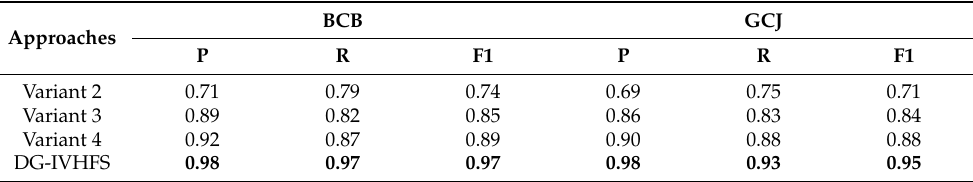
Table 4. The ablation experiment results on BCB and GCJ of